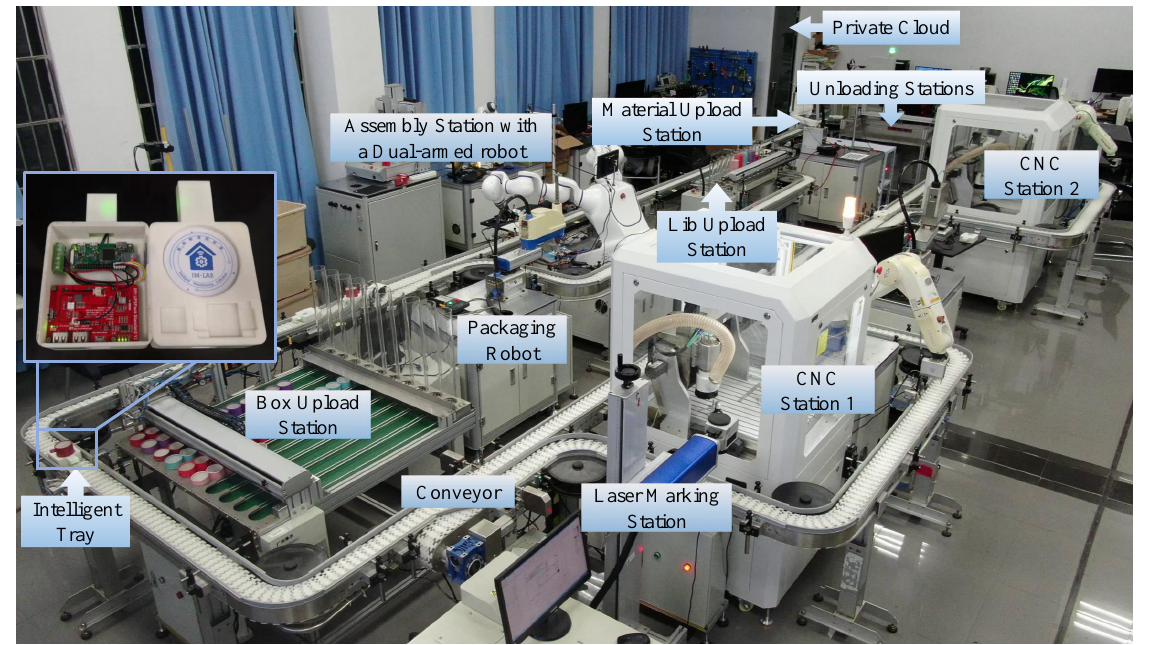
Figure 3. Intelligent factory experiment platform system